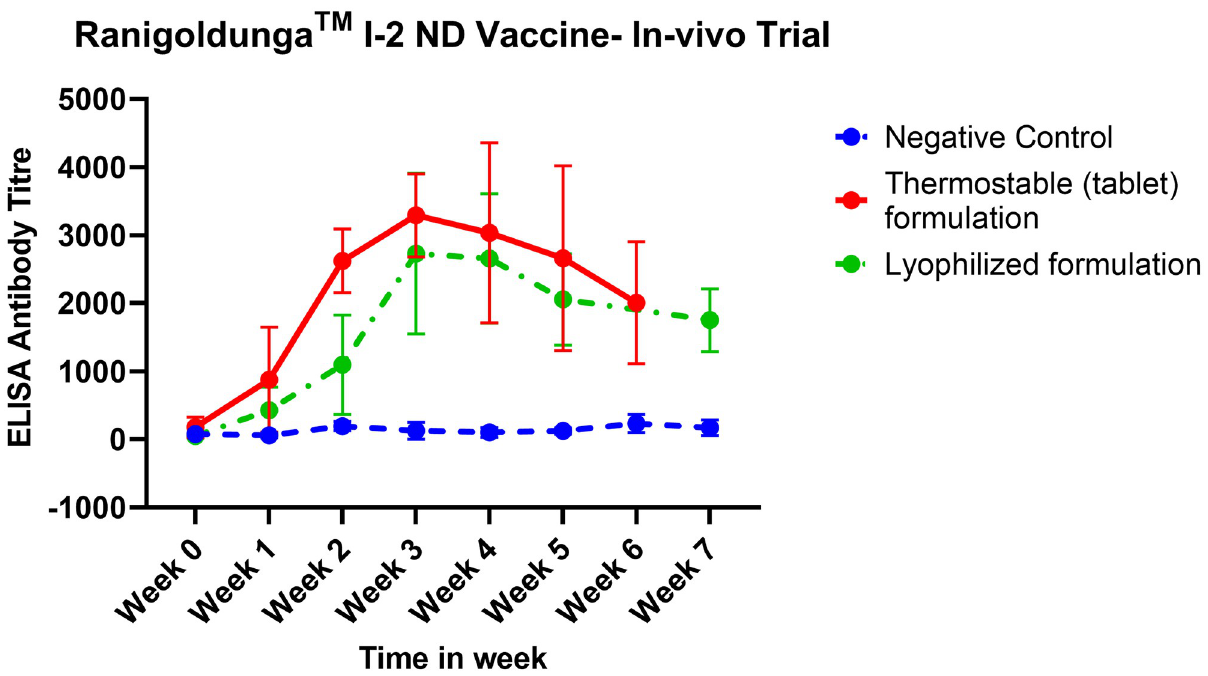
Fig 9. In-vivo measurement of NDV antibody titer after vaccination with the Ranigoldunga ™ . The Tablet formulation elevated NDV antibody titer to 4000 based on ELISA assessment. The graphs highlight antibody titer in chickens vaccinated with thermostable (tablet) formulation, lyophilized formulation, and negative control (unvaccinated chickens) from week 0 to week